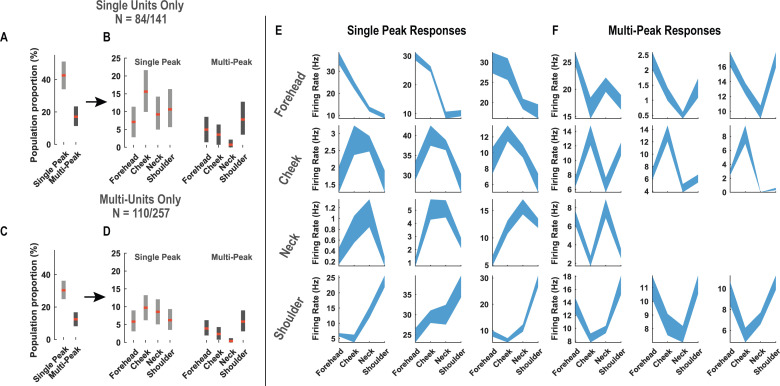
Diverse tactile receptive fields in human postcentral-intraparietal (PC-IP) neurons.Tactile receptive fields of PC-IP neurons were diverse with evidence both for broad single-and multi-peaked fields. Multi-peaked fields are defined as having spatially separated regions of enhanced response. (A) Percentage of neurons characterized by a broad single-peak response versus multiple peaks (mean ± 95% CI). The analysis is described in detail in 'Materials and methods: Spatial extent of single neuron responses'. In brief, for each neuron, we found the location of maximal response and asked whether we could find a second local maxima that rose significantly above the neighboring values. If no significant second local maxima was found, the neuron was categorized as single-peak; otherwise, the neuron was categorized as multi-peak. (B) Percentage of neurons characterized by a single peak versus multiple peaks split by their preferred response field (mean ± 95% CI). (C) Similar to A, but considering potential multi-units. (D) Similar to B, but considering potential multi-units. (E) Sample single-peak neuronal responses. Four rows depict sample units grouped according to their preferred response field (from top to bottom: forehead, cheek, neck, and shoulder). Within each panel, the neuron’s firing rate (in Hertz) is depicted as a shaded blue region (the width indicating the interval from [mean – 95% CI] to [mean + 95% CI], to each of the four labeled locations). (F) Sample multi-peak neuronal responses. Conventions as in C.